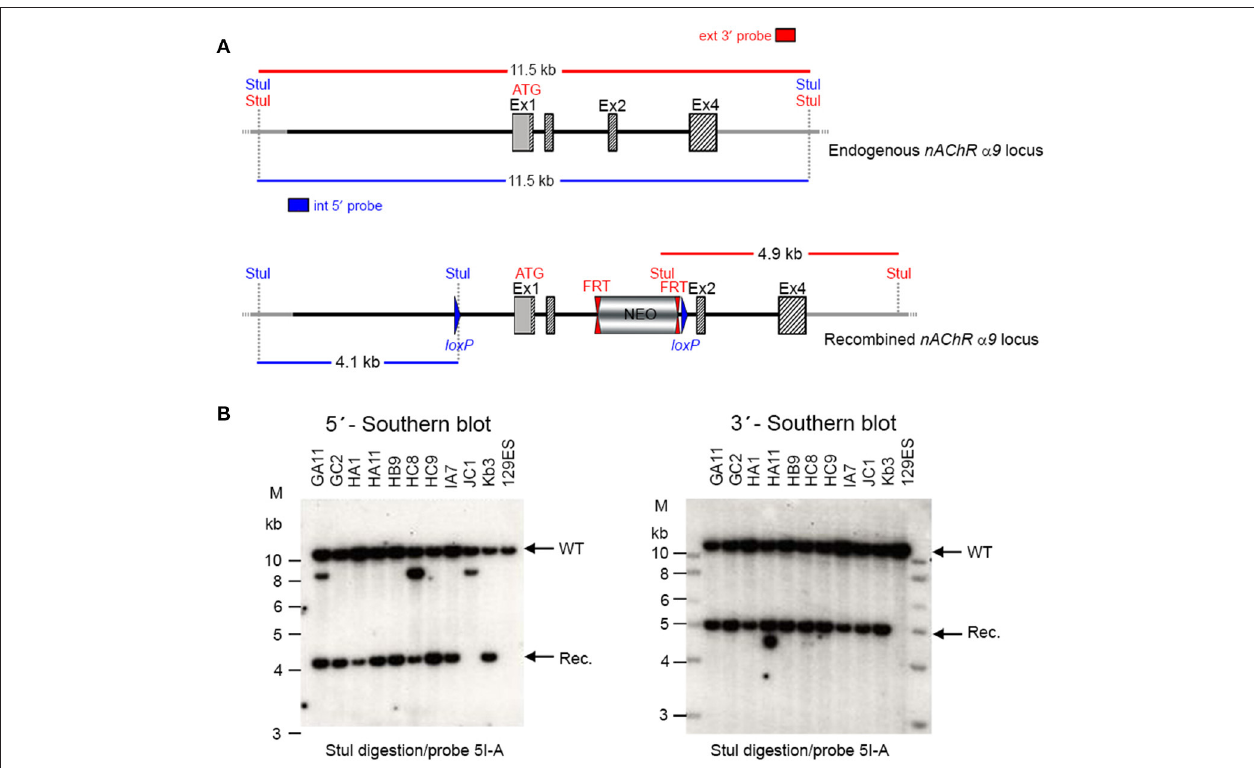
FIGURE 2 | (A) The schemata for the endogenous and recombined α 9 nAChR loci. (B) The Southern blot analysis for 5 ′ and 3 ′ homologous recombination in ES cells ( α 9 nAChR). The genomic DNA of the 10 tested ES cell clones was compared with wild type DNA from 129ES. Genomic DNA was digested with StuI. The digested DNA was blotted on nylon membrane and hybridized with either an internal 593 bp 5 ′ probe (5I-A) or the external 378 bp 3 ′ probe (3E-J) to screen for 5 ′ and 3 ′ homologous recombination. The internal 593 bp 5 ′ probe was generated by PCR on genomic DNA using the primer pair CTAAGGTGGCAGCAGAATGGAGTT CC/GCACGGGTACAAGGGTGAAGATGC. The 5 ′ probe hybridized downstream of the 5 ′ homology sequence of the targeting vector, which also allowed detection of the ES cell clones in which the targeting vector was integrated in a non-homologous manner. The 378 external bp 3 ′ probe was generated by PCR on genomic